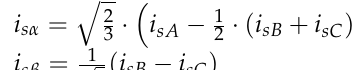
Figure 2. Effect of ITSCs in the PMSM stator winding on the waveform of the stator phase current envelope (phase A), experimental study ( T L = var, f s = f sN = 100 Hz).